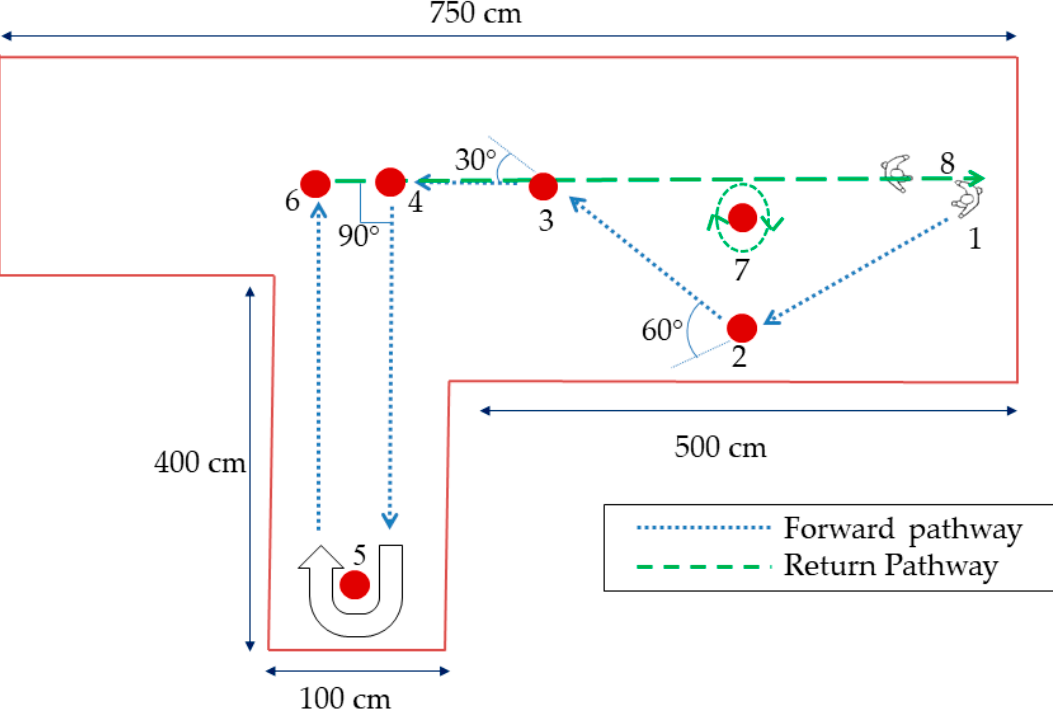
Figure 2. Walkway. 1. Start position, 2. 60 ◦ turn, 3. 30 ◦ turn, 4. 90 ◦ turn, 5. U-turn, 6. 90 ◦ turn, 7. Turn around a point, 8. Turn from spot, 1. Start position.